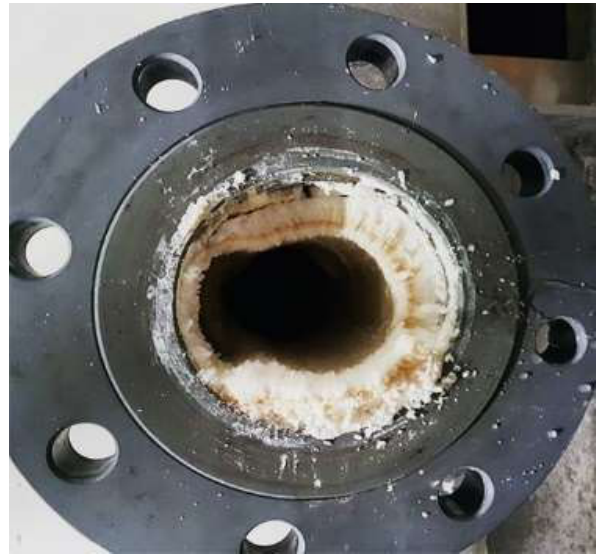
Figure 1. A sample of scale deposits accumulated in a